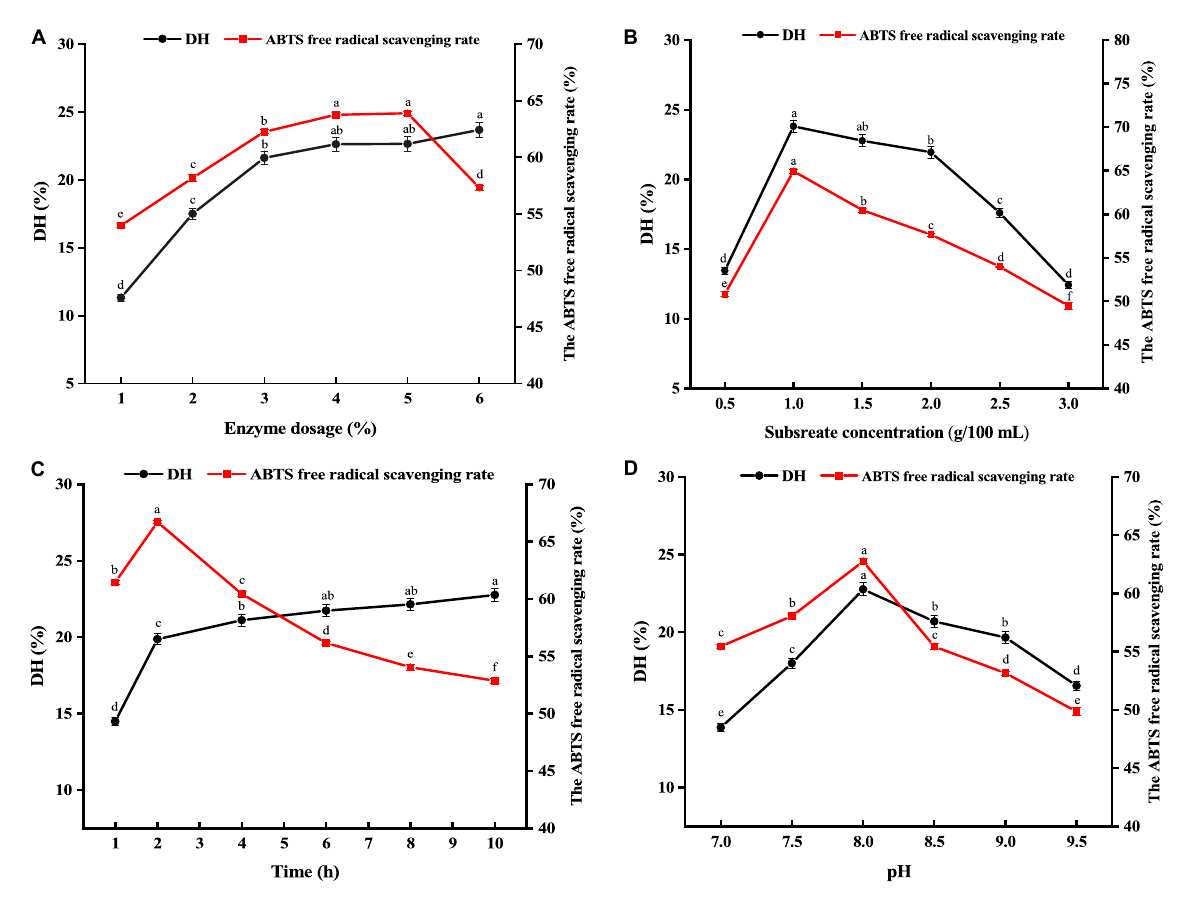
FIGURE1 Effects of enzyme dosage (A) , substrate concentration (B) , hydrolysis time (C) , and pH (D) on the degree of hydrolysis (DH) and ABTS free radical scavenging rate. Different lower cases above the error bar suggest obvious differences of groups ( p < 0.05).